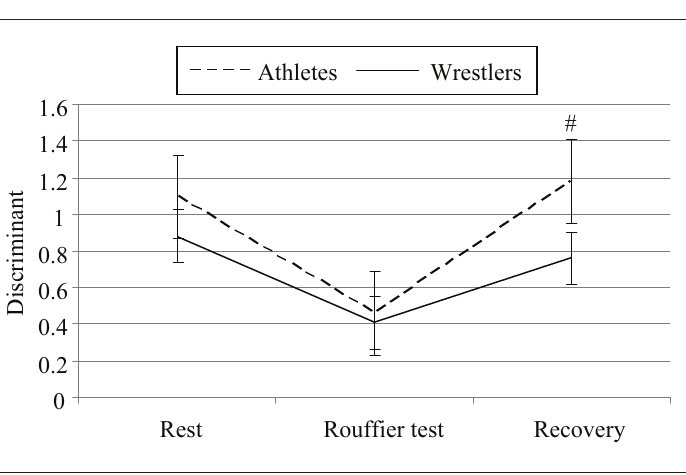
Figure 3. Dynamics of QRS complex and JT interval interaction (subsystemic level–regulatory processes) during dosed exercise test